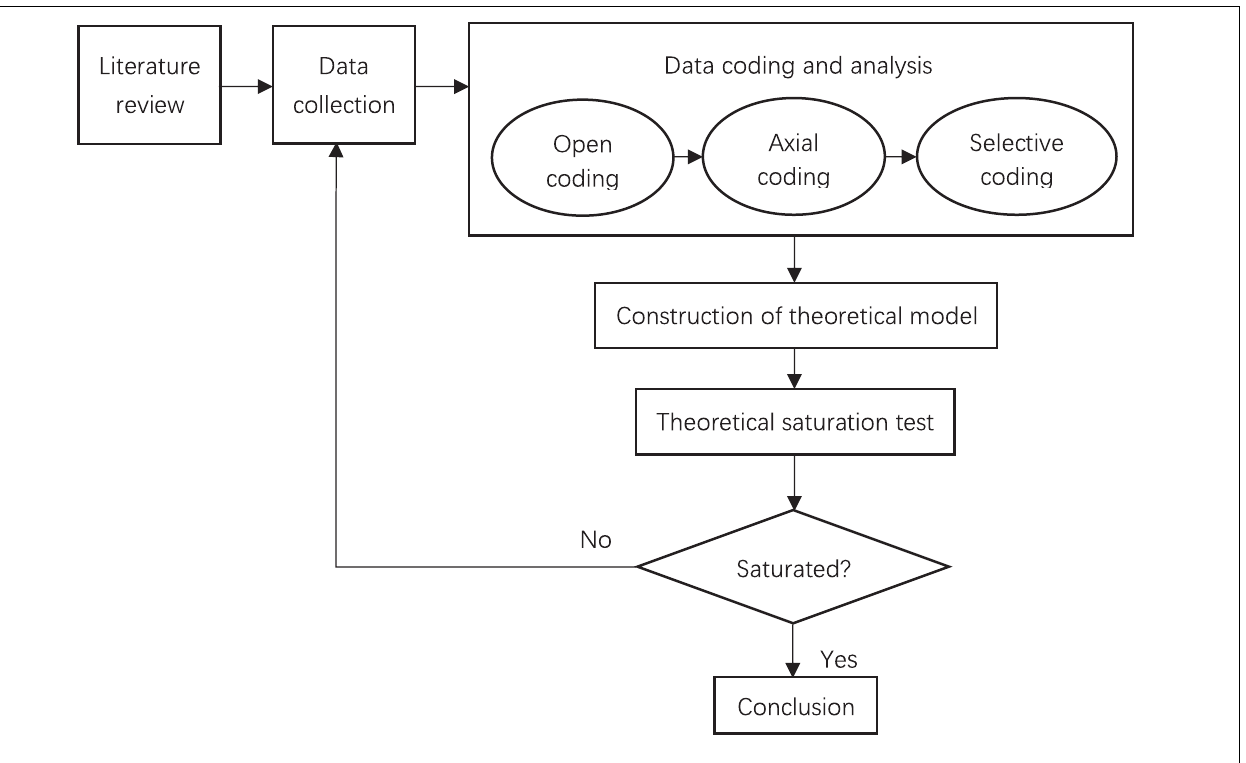
FIGURE 1 | Research process of grounded